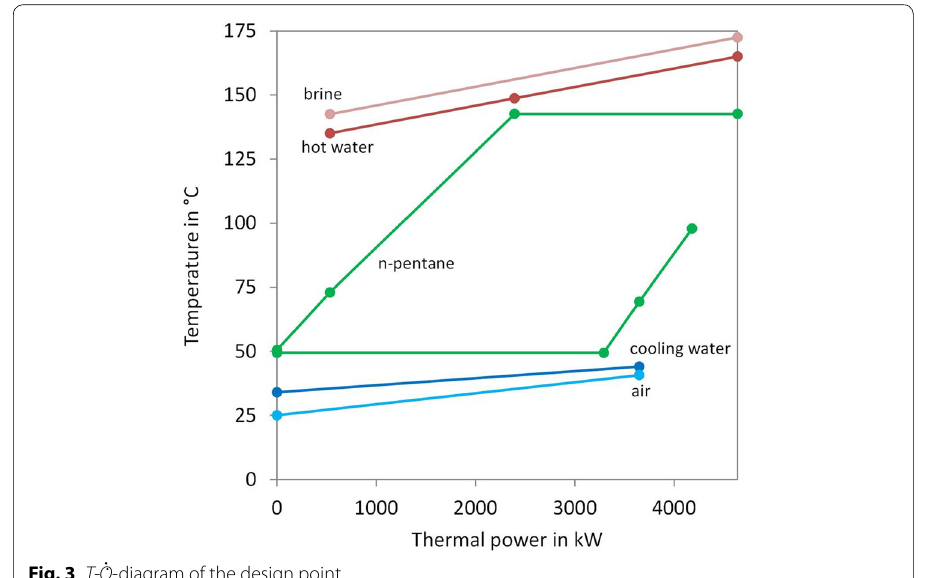
Fig. 3 T - ˙ Q ̇ -diagram of the design point